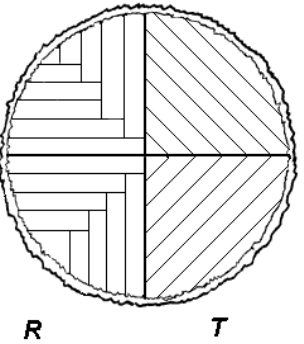
Figure 1. Sawing patterns to obtain radial and tangential samples.